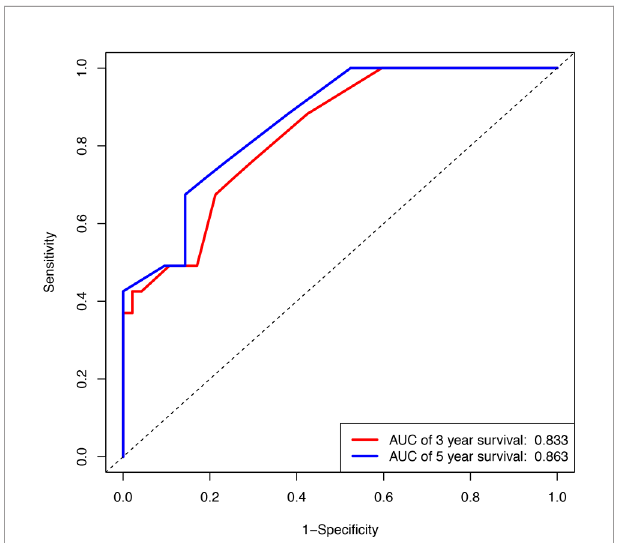
FIGURE 4 | Volcano plot of differentially expressed autophagy related genes between relapse and remission patients with bi CEBPA mutation. (FDR < 0.05, P < 0.05 and |log2 FC|>1.5).